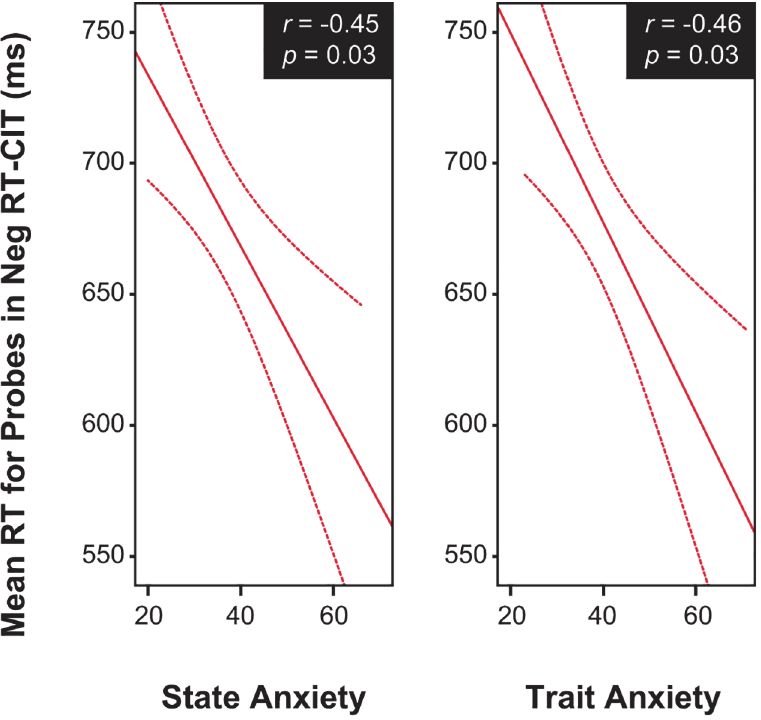
Fig 6. Estimated fit lines and their 95% confidence interval for the relation between RTs to probes and individual differences in state anxiety, trait anxiety.